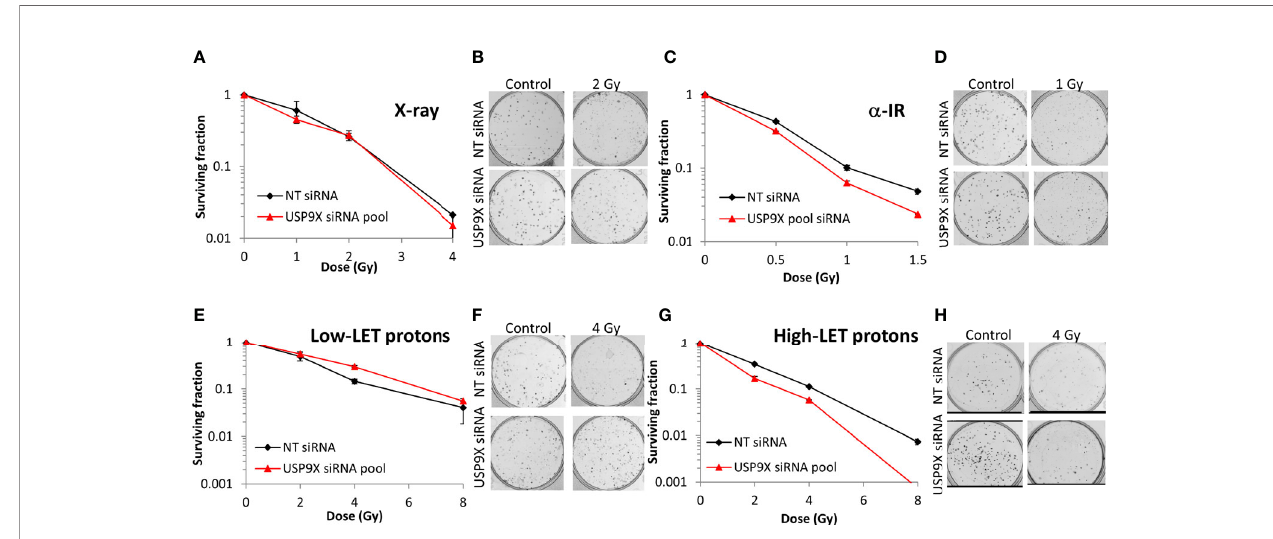
FIGURE 2 | Validation of USP9X in enhancing cellular radiosensitivity in response to high-LET a -particles and protons. HeLa cells were treated with USP9X siRNA (pool of 4 oligonucleotides) or a non-targeting (NT) control siRNA for 48 h and irradiated with increasing doses of (A, B) X-rays, (C, D) a -particles, (E, F) low-LET protons, or (G, H) relatively high-LET protons. Clonogenic survival of cells was analyzed from 2 independent experiments, and shown is the mean surviving fraction ± S.E. ( B, D, F, H ) Shown are representative images of colonies in non-irradiated and irradiated plates, the latter of which contained four times the number of cells